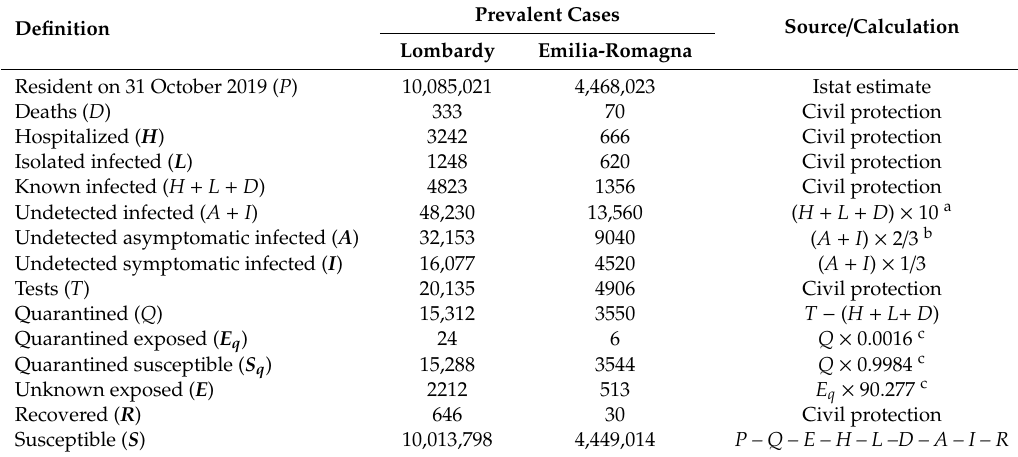
Table 2. Population sizes initialized in the extended SEIR model, Lombardy and Emilia-Romagna, 9 March 2020. The compartments included in the model are in